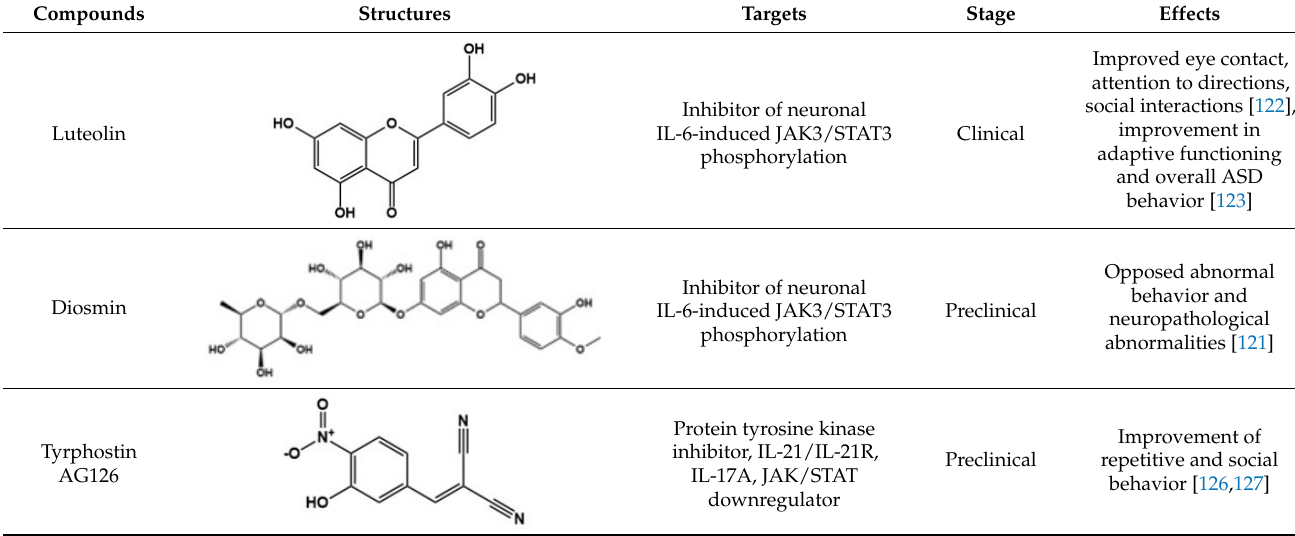
Molecules 2022 , 27 , x FOR PEER